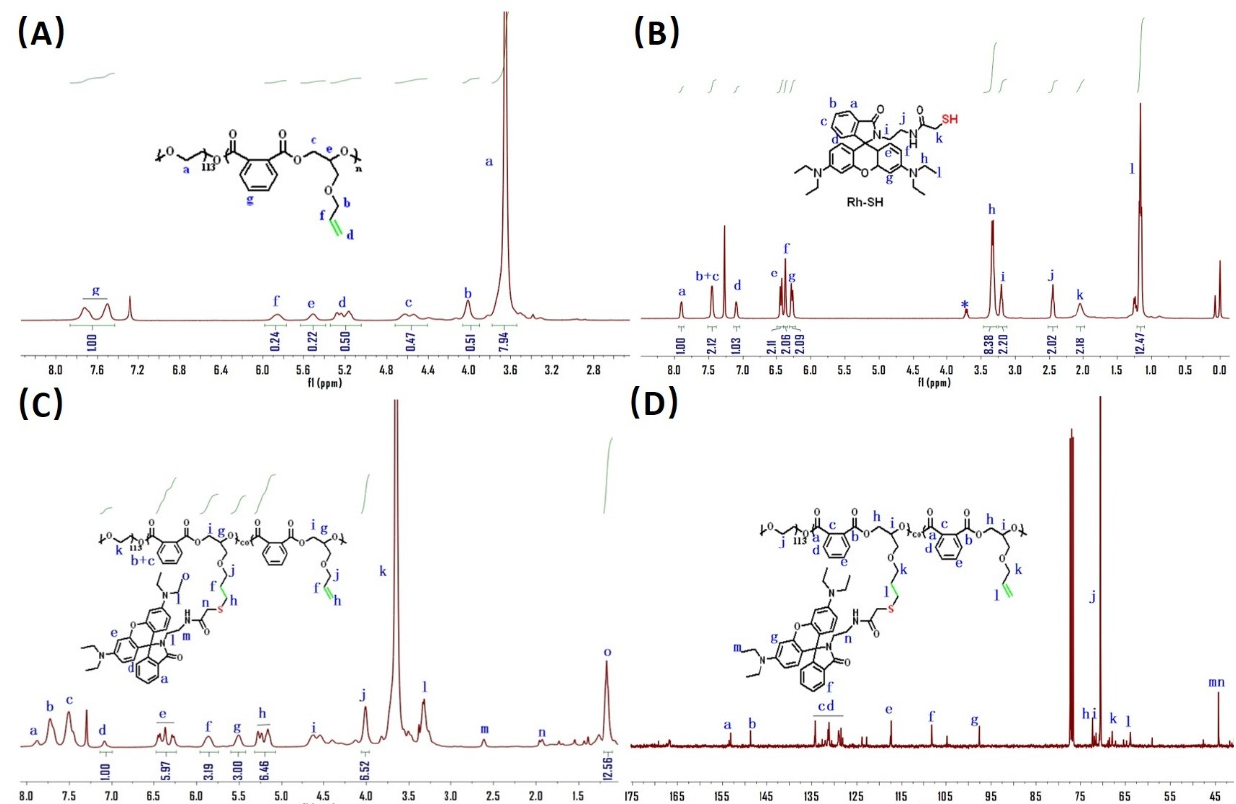
Figure 2. ( A ) 1 H NMR spectrum of the mPEG-b-P(PA-alt-AGE) copolymer (400 MHz, CDCl 3 ); ( B ) ( A ) 1 H NMR spectrum of the mPEG-b-P(PA-alt-AGE) copolymer (400 MHz, 1 H NMR spectrum of RhB-SH (400 MHz, CDCl 3 ); ( C ) 1 H NMR spectrum of rhodamine-functional- CDCl 3 ); ( B ) 1 H NMR spectrum of RhB-SH (400 MHz, CDCl 3 ); ( C ) 1 H NMR spectrum ized mPEG-b-P(PA-alt-AGE) copolymer (400 MHz, CDCl 3 ); ( D ) 13 C NMR spectrum of rhodamine- functionalized mPEG-b-P(PA-alt-AGE) copolymer (400 MHz, CDCl 3 ).